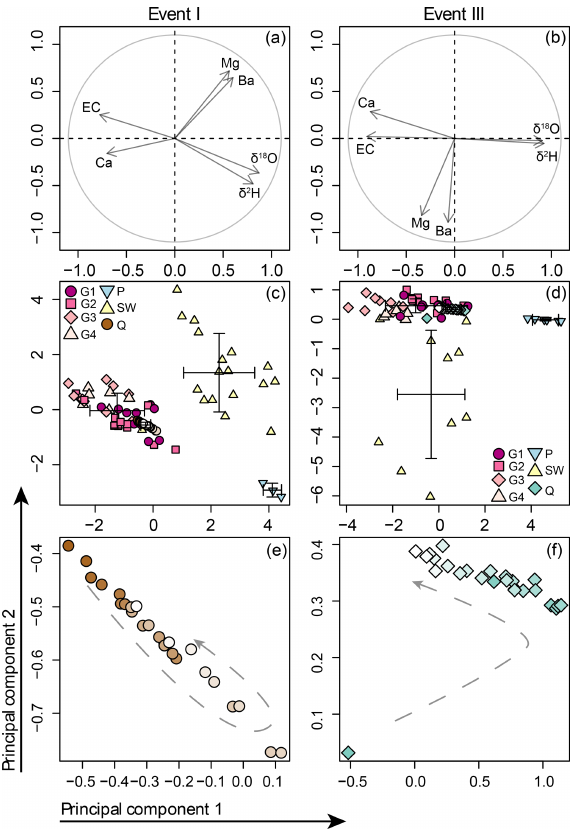
Figure 7. PCA results and mixing diagrams for events I (small event) and III (intermediate-sized event). In the biplots (a) and (b) , the length of the arrow represents the explanatory power. The mix- ing diagrams based on the first two principal components ( c and d ) show the individual rainfall (light blue triangles), soil water (yellow triangles) and groundwater samples (purple circles, pink squares, light pink diamonds and rose triangles representing groundwater types 1–4; based on Kiewiet et al., 2019), and the streamflow ( Q ) samples and average and standard deviation for each component (er- ror bars). Panels (e) and (f) show an enlargement of the streamflow samples and highlight the evolution of the stream water composition (colours fade to white towards the end of the event); the general di- rection of change is indicated with a grey arrow and broken lines. The biplots and mixing plots for the events II and IV are shown in Fig. S4.